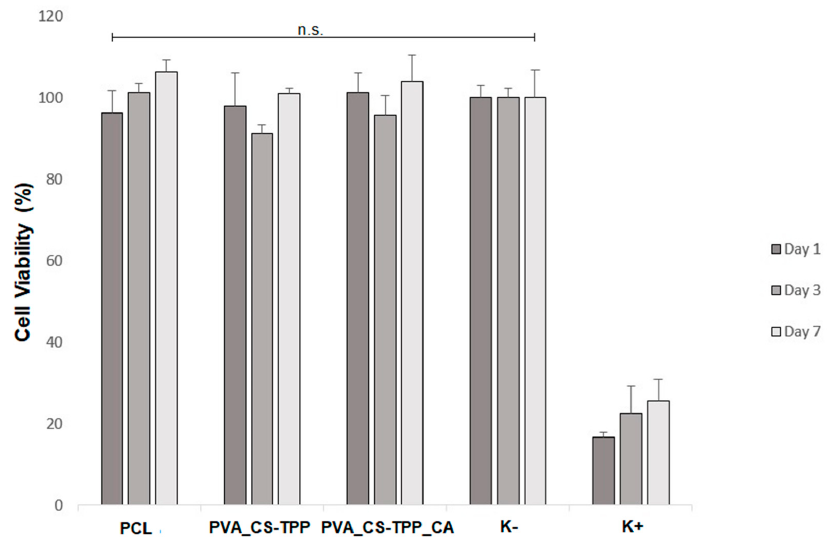
Figure 7. Growth of normal human dermal fibroblasts (NHDF) cells on the PCL’s top layer and the PVA_CS-TPP and PVA_CS-TPP_CA’s bottom layers detected by 3-(4,5-Dimethyl-2-thiazolyl)-2,5- 3-(4,5-Dimethyl-2-thiazolyl)-2,5-diphenyl-2H-tetrazolium bromide (MTT) assay in term of cell diphenyl-2H-tetrazolium bromide (MTT) assay in term of cell viability after 1, 3, and 7 days.